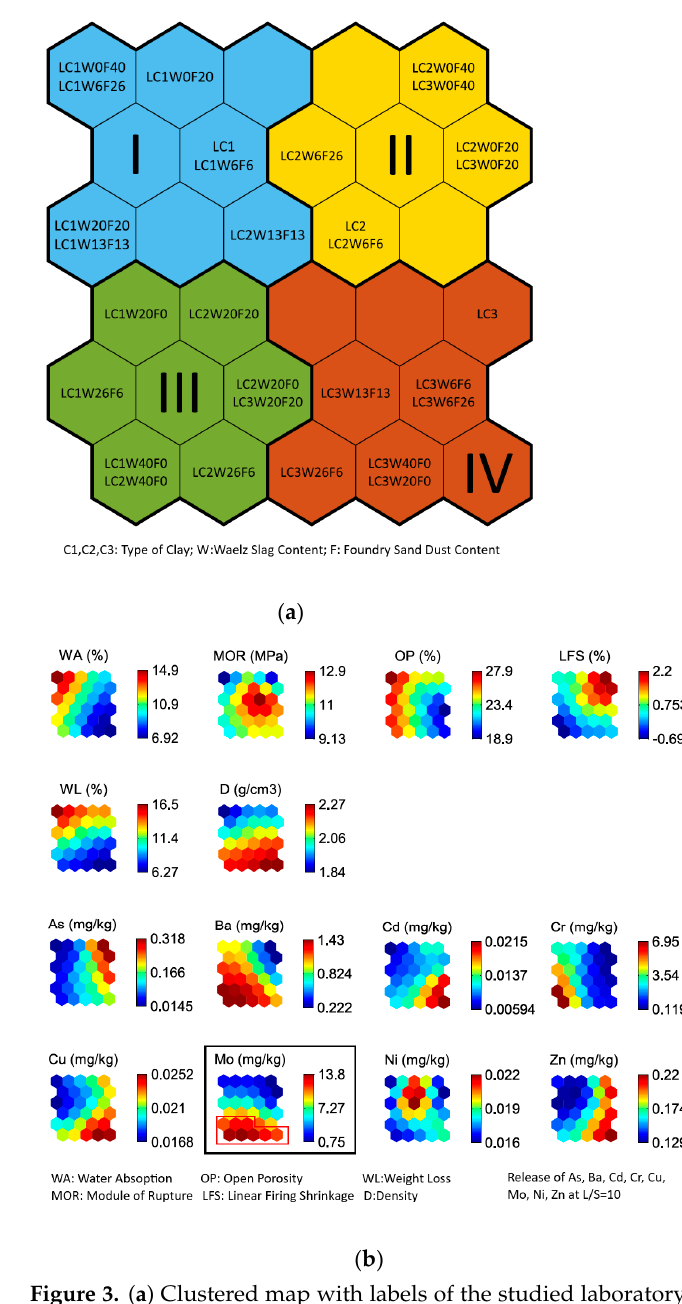
Figure 3. ( a ) Clustered map with labels of the studied laboratory pressed clay mixtures with WS-FSD incorporation. The 4 clusters (I–IV) have been derived from the k-means algorithm applied to the trained SOM. The labels in the hexagons of the map show the BMU (Best Matching Unit) corresponding to each sample. ( b ) Component planes of the SOM for the 14 input variables with Mo highlighted along with neurons that exceed non-hazardous landfill limits. Each map corresponding to one variable (component) should be compared to the map representing the distribution of the laboratory pressed clay mixtures with WS-FSD incorporation presented in Figure 3a; hexagons in the same place on different component planes correspond to the same map unit. The colours indicate the value of the component in the weight vector of each unit of the map, according to the colour bars on the right.